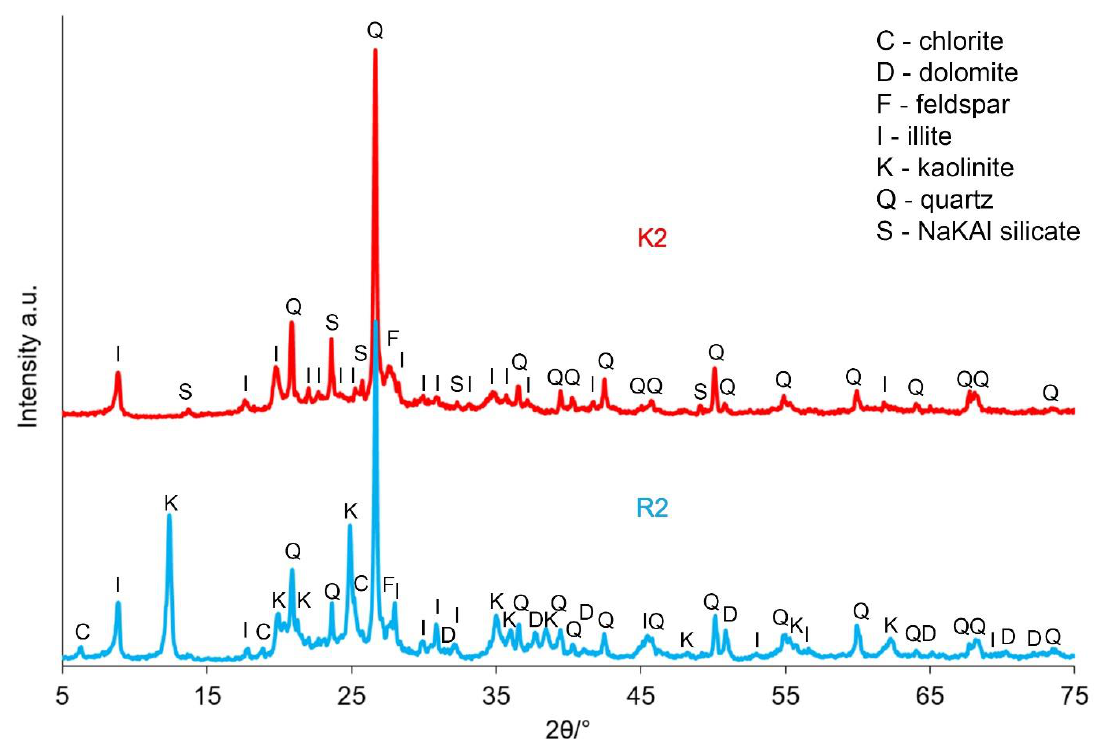
Figure 3. XRD patterns of a sample taken from the Piast hard coal mine, both before (R1) and after the calcination process (K1).